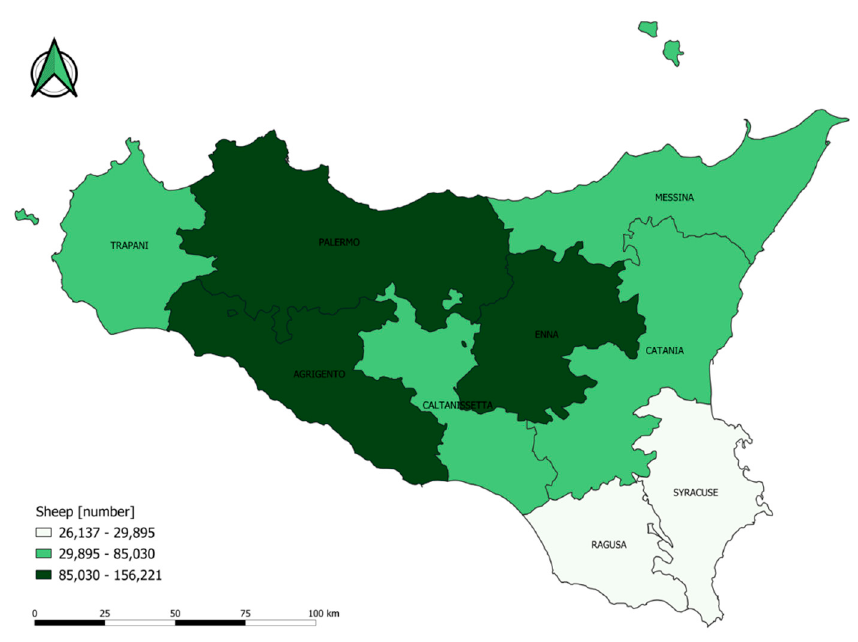
Figure 4. Sheep distribution within the study area (Sicily) at a provincial level.